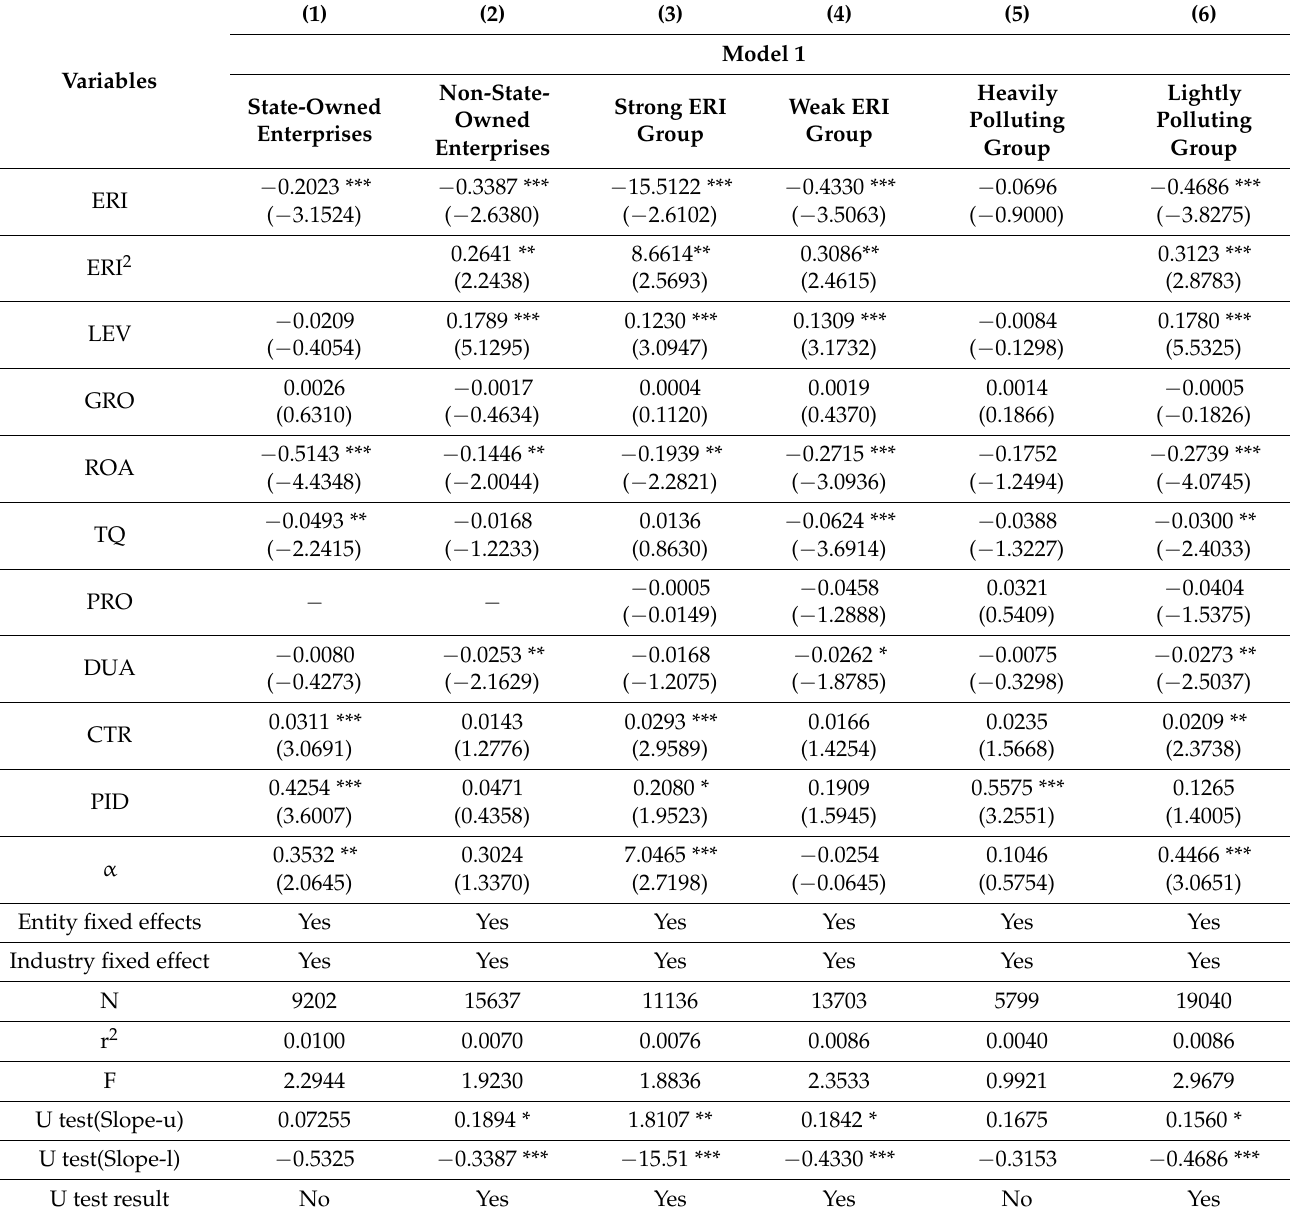
Table 6. Heterogeneity test of the impact of ERI on green